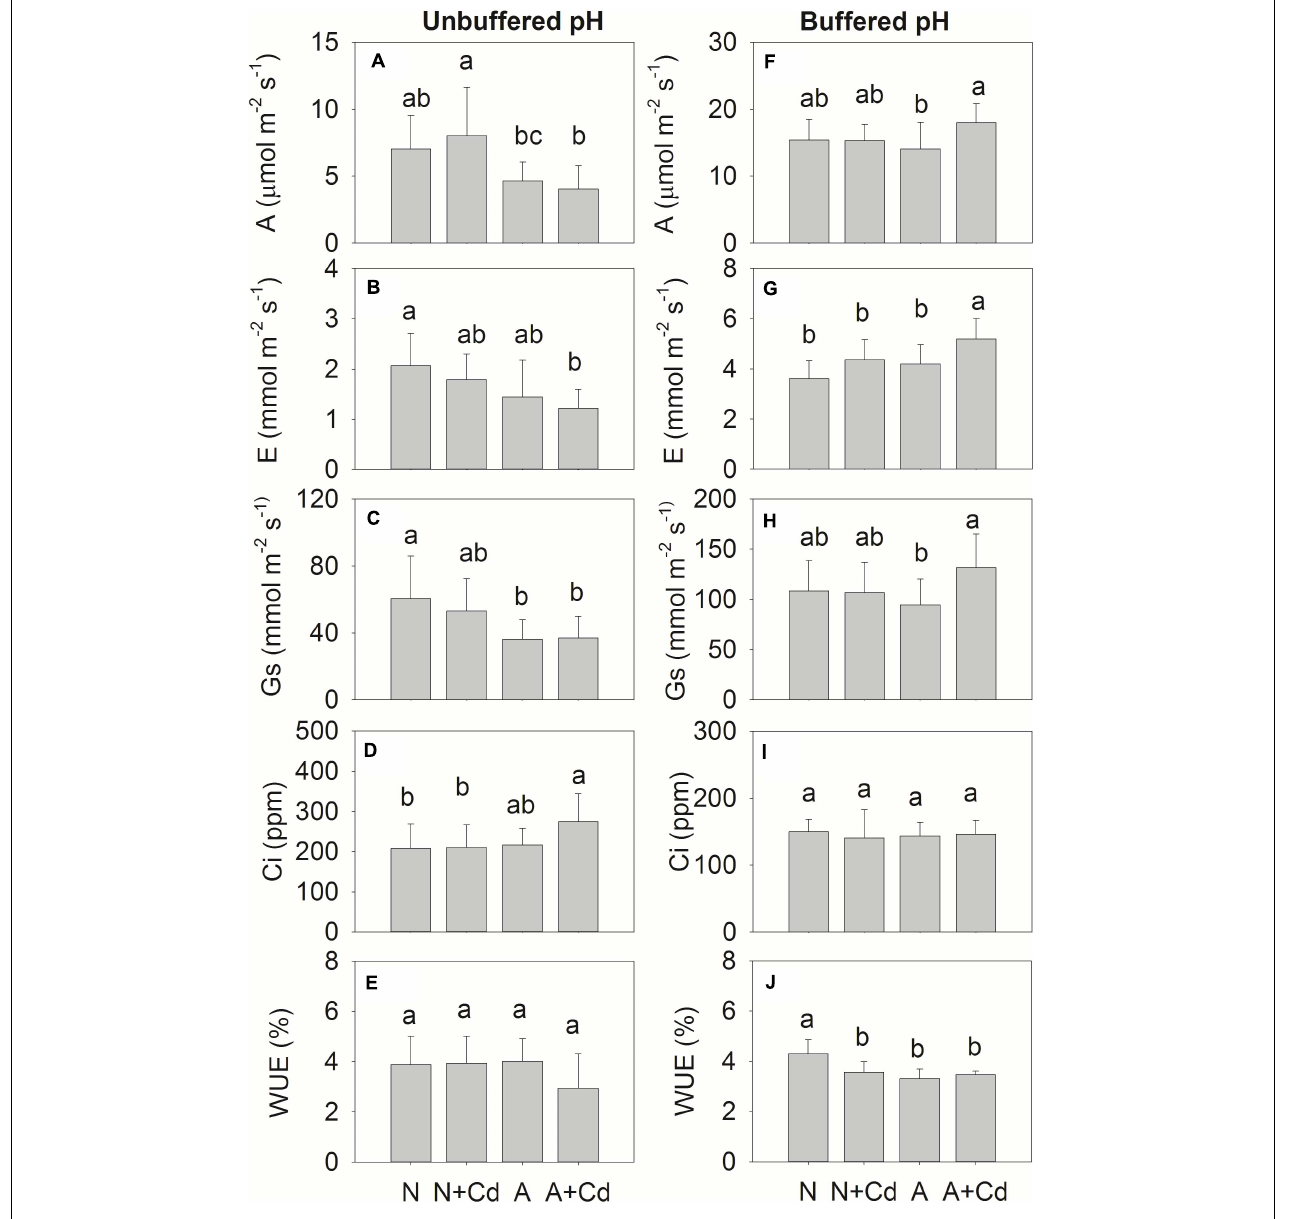
FIGURE 4 | Net photosynthesis rate (A), transpiration rate (E), stomatal conductance (Gs), intercellular CO 2 concentration (Ci) and water use efficiency (WUE) in leaves of sweet sorghum as affected by nitrate and ammonium in the presence or absence of Cd under unbuffered (A–E) or buffered (F–J) pH condition. N, nitrate; N + Cd, nitrate with Cd; A, ammonium; A + Cd, ammonium with Cd. Different letters above the bars represented significant differences at the level of 0.05 based on One-Way ANOVA and Duncan’s multiply